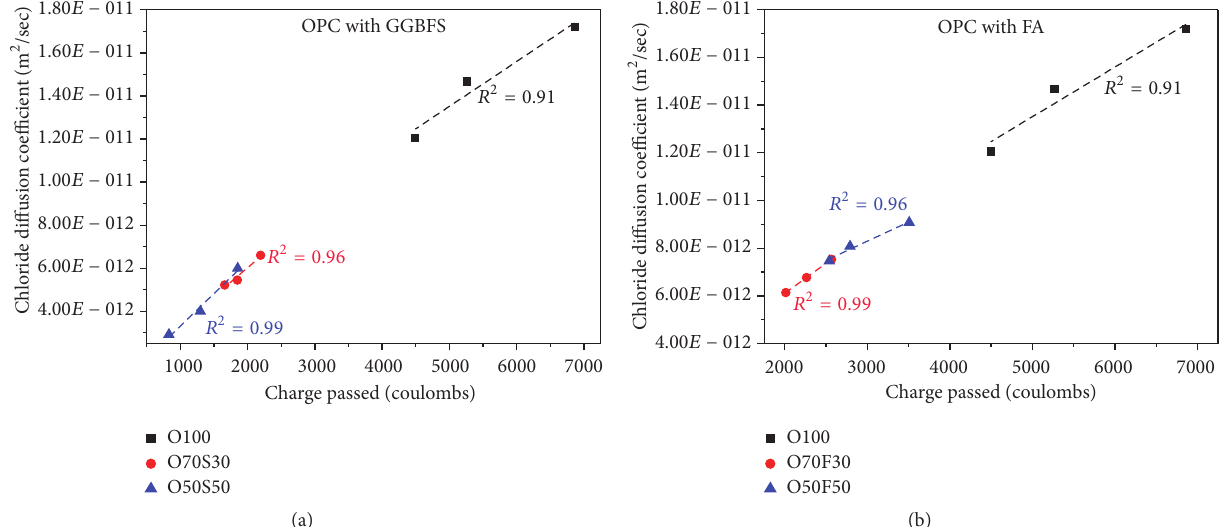
Figure 8: Correlation graph between charge passed coulomb versus chloride diffusion coefficient: (a) GGBFS in HPC and (b) FA in